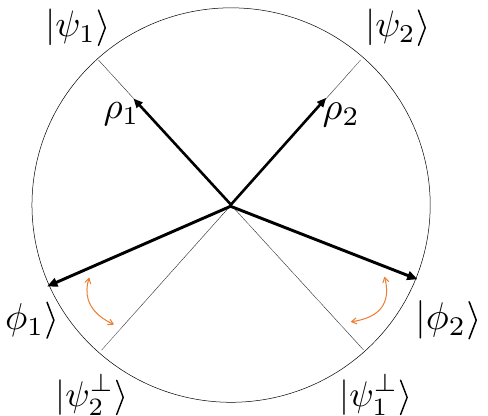
FIG. 4. The maximum confidence is computed for a pair of quantum states (solid) and also in a noncontextual model (dashed). The noise parameter is denoted by p ∈ [0, 1] [see Eqs. (18) and (20)]: the case p = 0 reproduces UD. Contextual advantages for an MCM of noisy quantum states are shown for p ∈ ( 0, 1 ) .